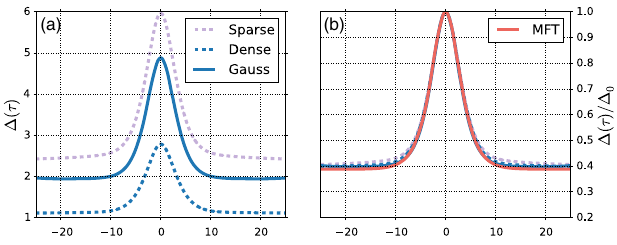
FIG. 5. Robustness to changes in the synaptic distribution . (a) Autocorrelation function for sparse ( p ¼ 0 . 05 ), dense ( p ¼ 0 . 8 ), and Gaussian connectivity networks ( N ¼ 7000 , h 0 ¼ 1 ). The gains were chosen such that all networks have the same variance for the connectivity distribution ( g ¼ 2 . 8 for ffiffiffiffiffiffiffiffiffiffiffi p 1 − p the Gaussian distribution and g ¼ 2 . 8 for the